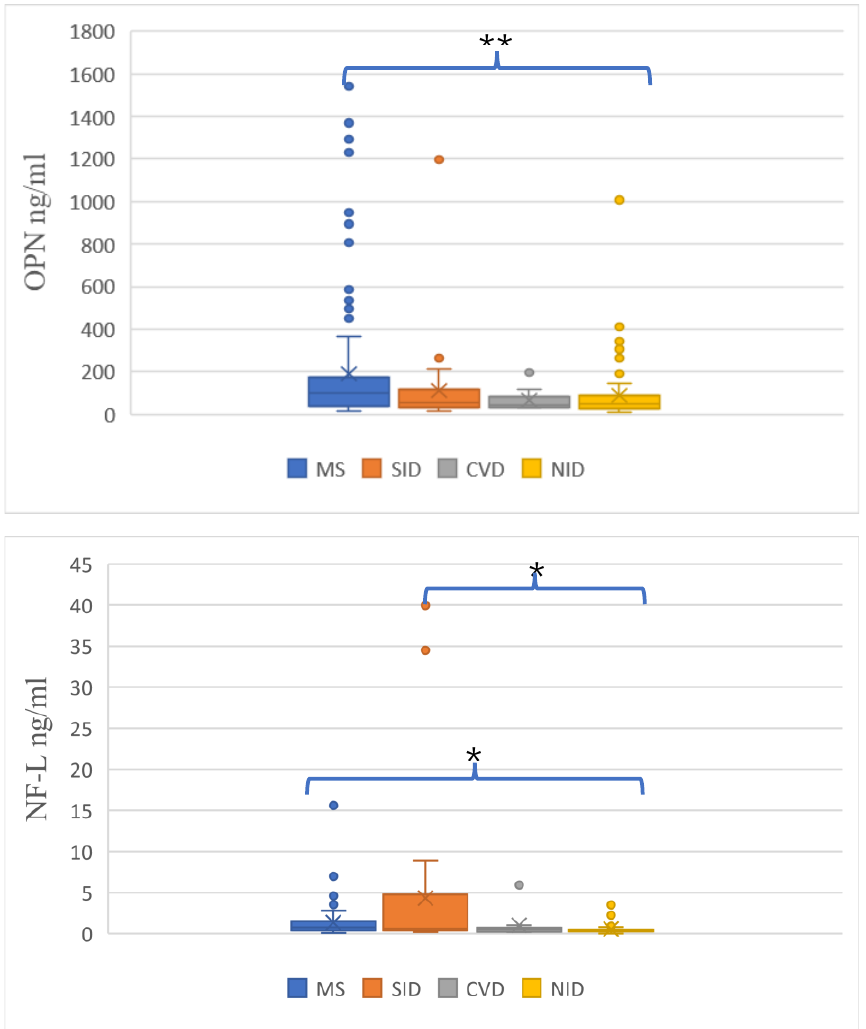
Figure 1. CSF concentration of IL6, OPN and NF-L. IL-6 ( p = 0.035) and NF-L ( p = 0.002) level was significantly higher in SID compared to NID patients. Significantly higher level of OPN ( p = 0.000) and NF-L ( p = 0.002) in MS compared to NID population was noted. * means significant differences p < 0.05; ** means significant differences p <